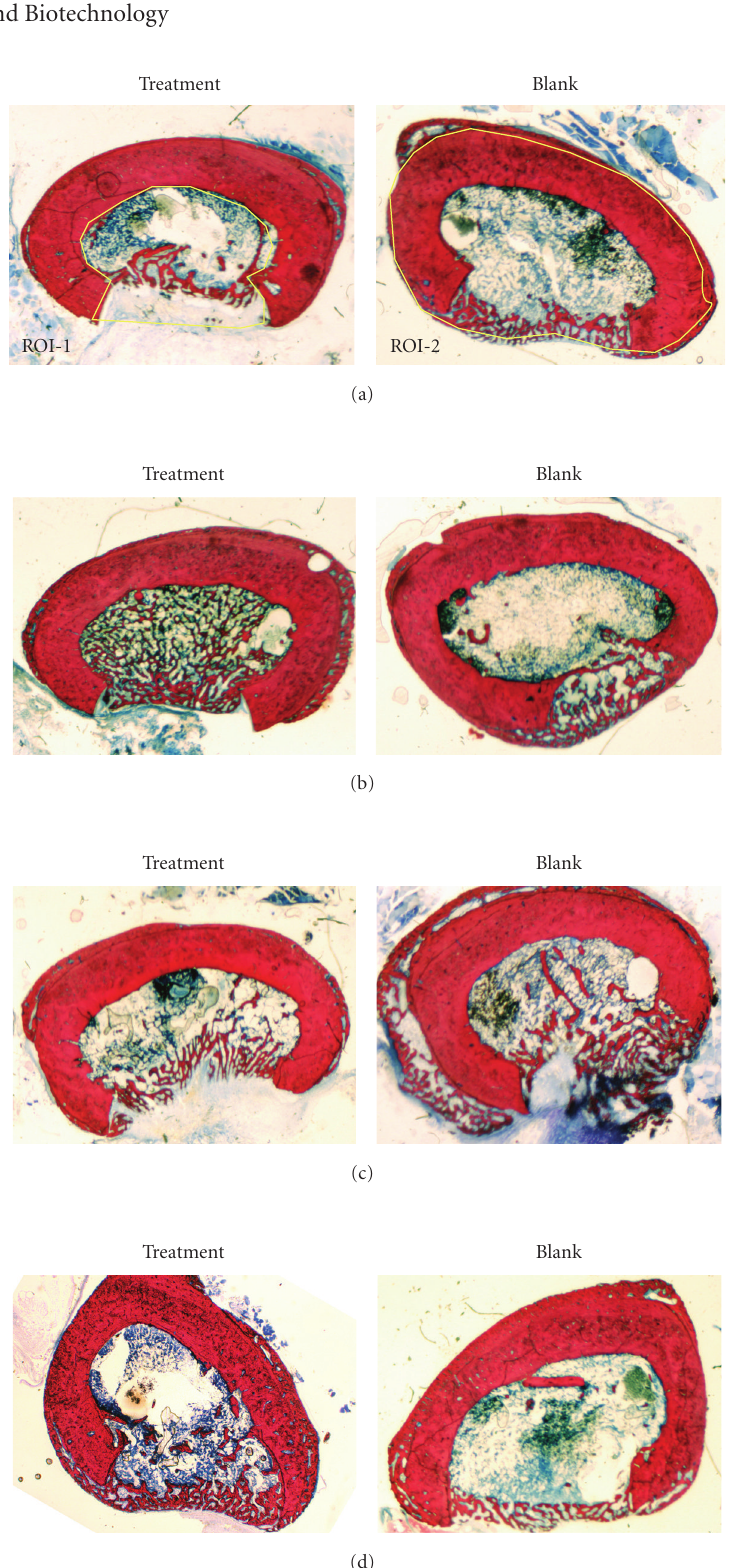
Figure 4: Histological Sections of Femur Defects . Following micro CT evaluation, specimens were plastic embedded, sectioned through the defect, and stained for mineralized tissue (red) and cartilage (deep blue). Shown are representative cross-sections from (a) an empty defect and defects treated with (b) high-dose alendronate, (c) high-dose lovastatin, and (d) high-dose omeprazole. ROI-1 is shown and included the defect site and marrow space (a)-left. ROI-2 is shown and bone outside of ROI-2 was considered peripheral bone formation (a)-right. Corresponding blank-treated defects from each treatment group are shown in the right column. Mineralized tissue was evident in all defect sites but little or no cartilage was